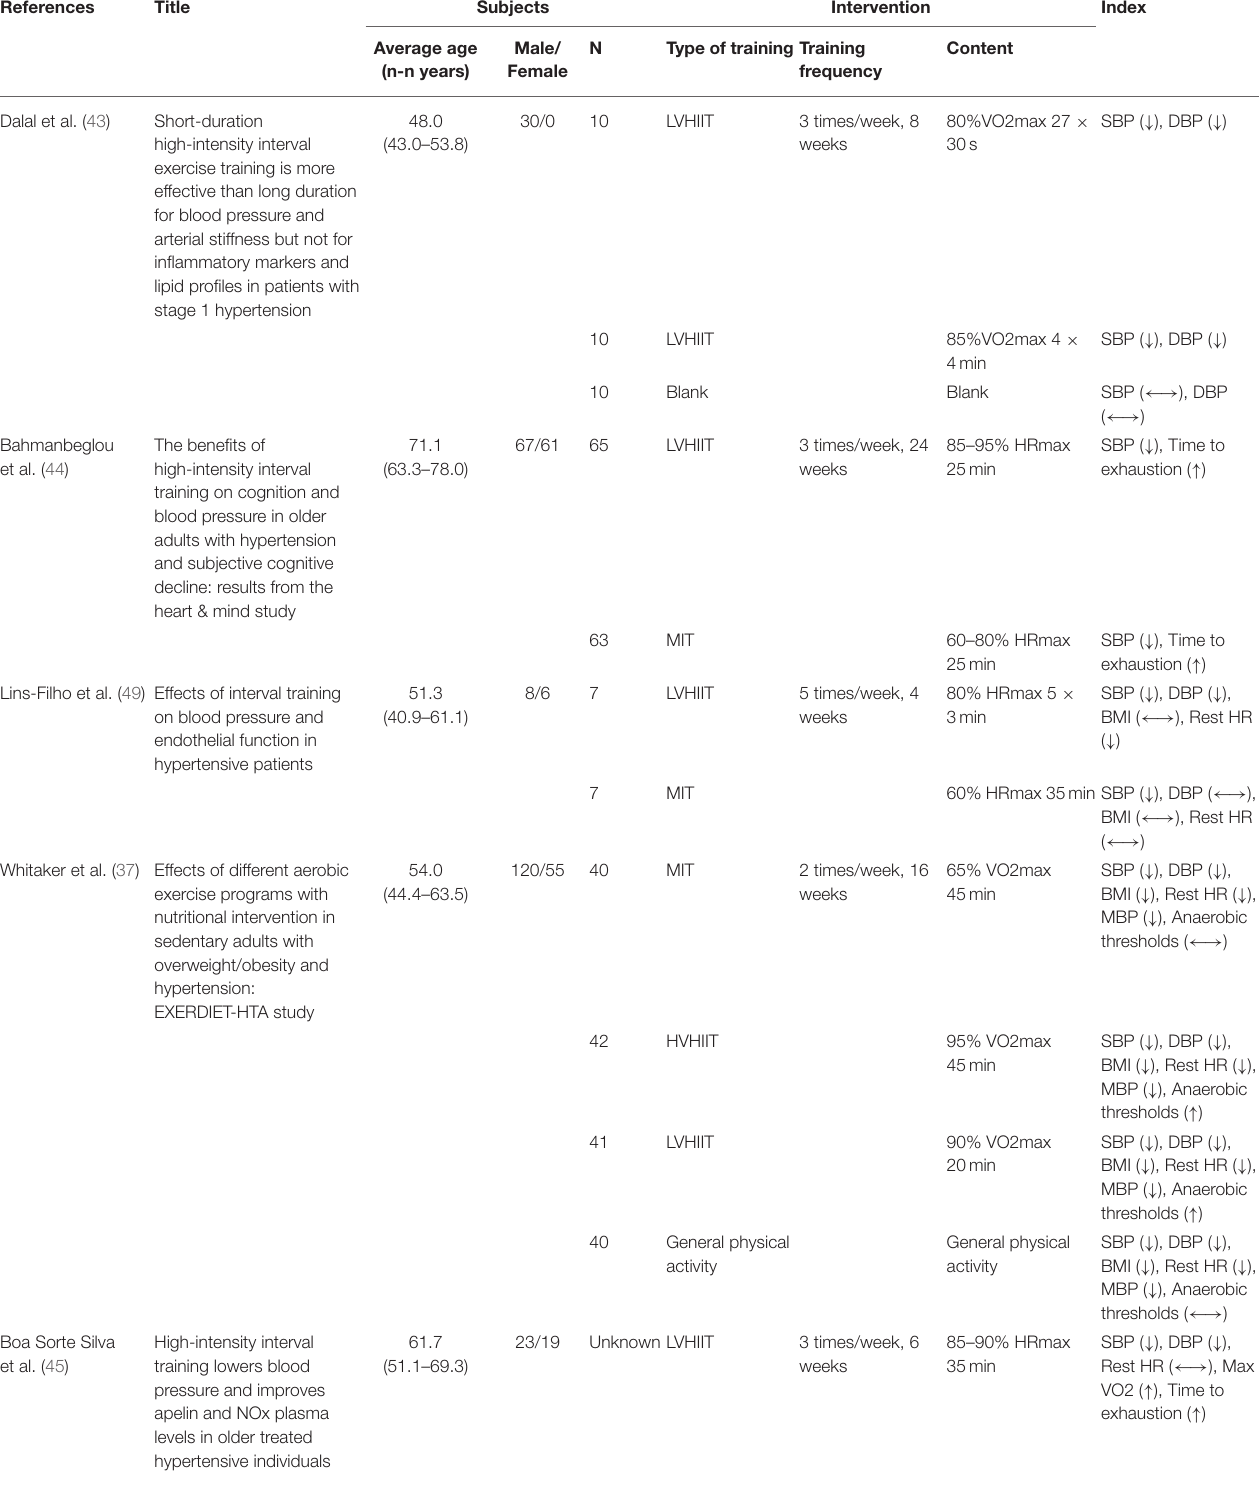
TABLE 1 | The study characteristics of included